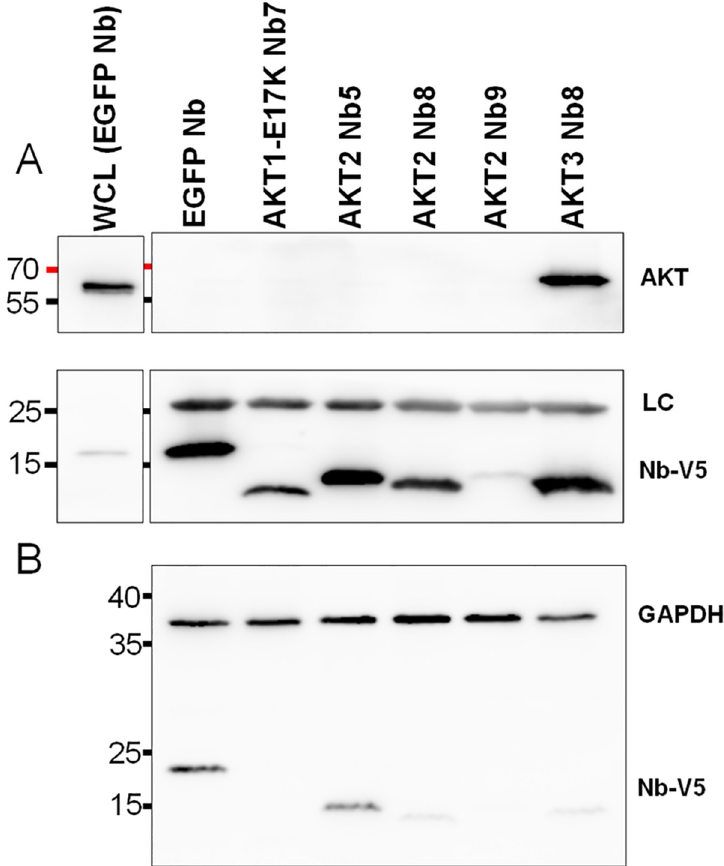
Fig 6. Co-IP of endogenous AKT from MDA-MB-231 cells with Nbs transiently expressed as intrabodies. (A) Co- IP of AKT and Nbs. WCL = whole cell lysate from EGFP Nb transfected cells, The negative control were cells with transient expression of the EGFP Nb. LC = Light Chain. (B) Nb expression in crude lysate. 10 μ g crude lysate from transfected cells was analysed through SDS-PAGE and western blotting. GAPDH signal was used as loading control. AKT was detected using a pan-AKT antibody (C67E7), Nbs were detected using an anti-V5-antibody. Uncropped blots are available in S1 Raw